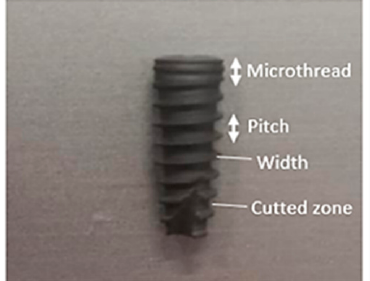
Figure 5. Example of a dental implant with cutted zone.